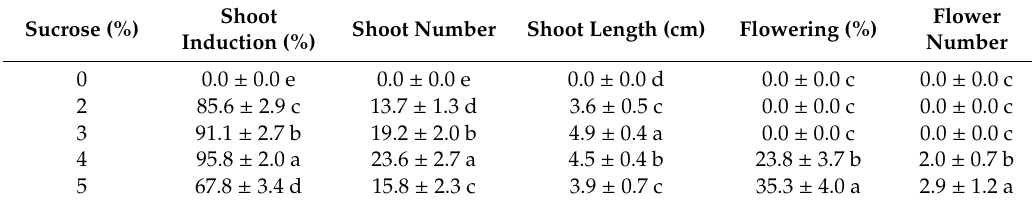
Table 4. E ff ect of sucrose on in vitro multiple shoot induction and flowering of Catharanthus roseus.